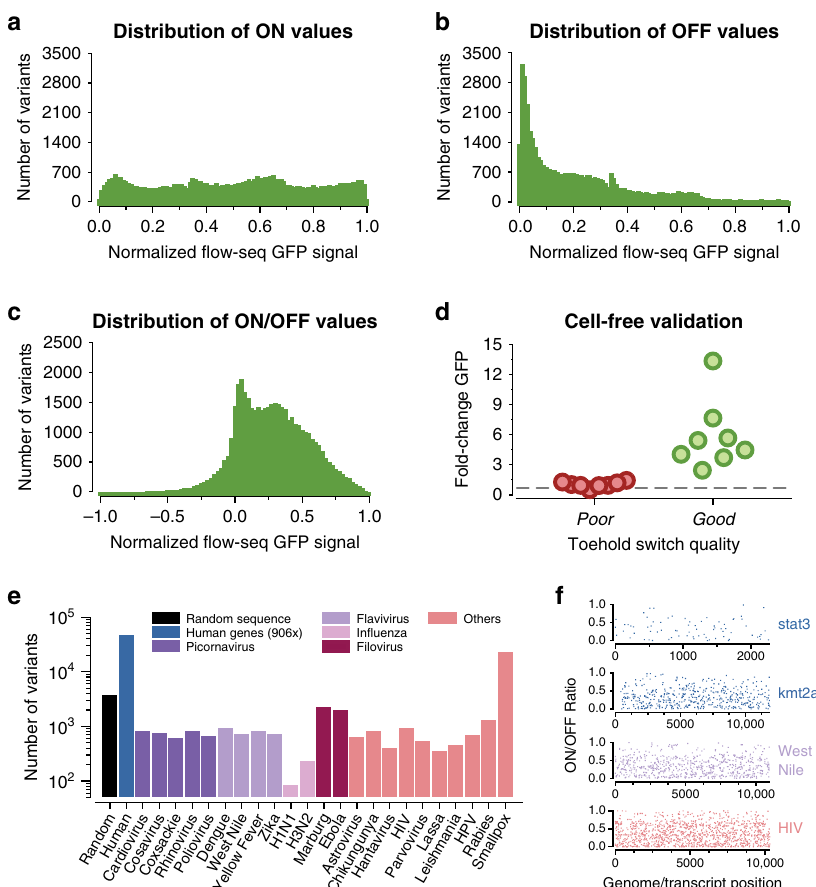
Fig. 2 Flow-seq toehold-switch library characterization and trigger ontology. The distribution of recovered toeholds for ( a ) ON-state signals, ( b ) OFF- state signals, and ( c ) calculated ON/OFF ratios are shown. d Validation results for toehold switches expressed in a PURExpress cell-free system with un- fused-trigger RNA, including eight low-performing (poor, ON/OFF < 0.05) and eight high-performing (good, ON/OFF > 0.97) samples. Obtained in vivo fl ow-seq data show competency in classifying switch performance for this in vitro cell-free biological context ( P < 0.0001 between high and low switches, two-tailed t test) with n = 3 biologically independent samples each for both ON and OFF measurements. e Tested switch/trigger variants from each origin category, including randomly generated sequences, 906 human transcription factor transcripts, and 23 pathogenic viral genomes. f Experimental ON/OFF ratios for all triggers tiled across the transcripts of two clinically relevant human transcription factors ( stat3 and kmt2a ) upregulated in cancerous phenotypes 51,52 , as well as all triggers tiled across the genomes of two pathogenic viruses: West Nile Virus (WNV) and human immunode fi ciency virus (HIV). GFP green fl uorescent protein, Seq sequence, HPV human papillomavirus. All ON, OFF, and ON/OFF values shown were selected from quality control process #3, QC3 in Supplementary Fig. S13 and Supplementary Table 1. All source data are provided as a Source Data fi